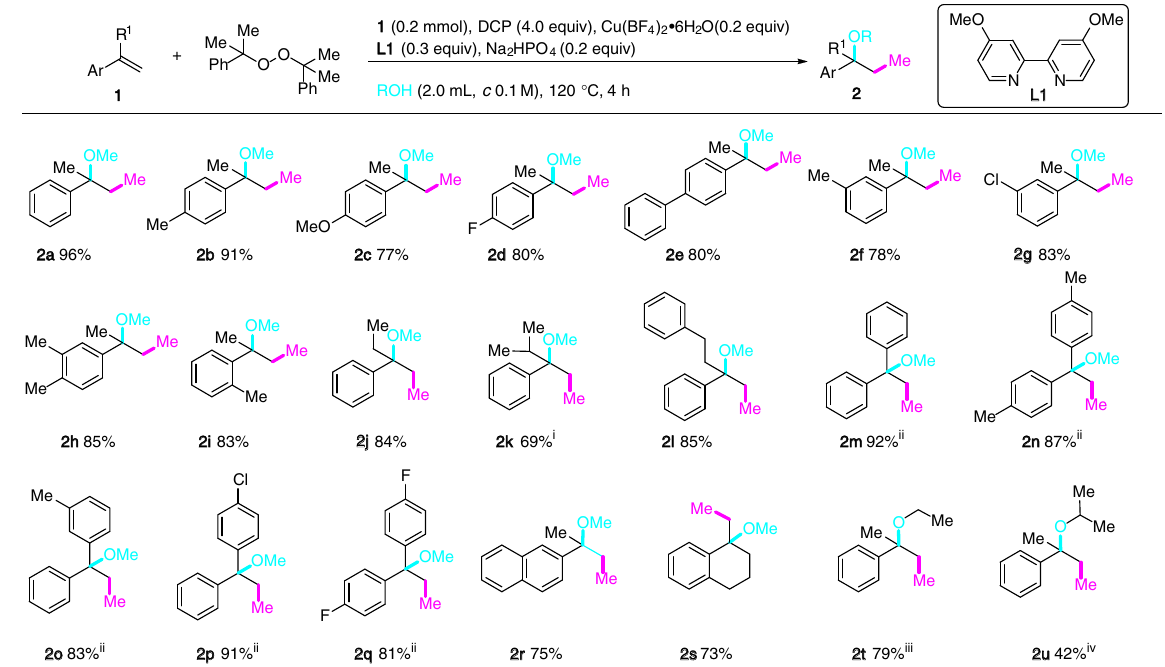
Fig. 2 1,2-Alkoxy methylation of unactivated alkenes. Unless speci fi ed, MeOH was used as solvent. (i) 140 °C; (ii) DTBP (4.0 equiv) was used instead of DCP; (iii) EtOH (2.0 mL, c 0.1 M); (iv) i PrOH (2.0 mL, c 0.1 M). Abbreviations: DTBP di- tert -butyl peroxide; DCP dicumyl 2-hydroperoxy-2-methylbutane as ethyl donor under otherwise standard conditions provided a complex reaction mixture. The scope of this 1,2-alkoxy methylation of alkenes is shown in Fig. 2. Electron-donating (Me and OMe) and electron- withdrawing (F and Cl) substituents at different positions of the phenyl ring of the α -methylstyrene derivatives were transformed into the corresponding methylated ethers ( 2b – 2i ) in excellent yields. Different alkyl groups (Et, i Pr, and CH 2 CH 2 Ph) at the α - position of styrene were compatible ( 2j – 2l ) and the 1,1- diarylethylenes were similarly difunctionalized to afford the desired products ( 2m – 2q ) regardless of the electronic nature of the substituents on the aromatic ring. 2-Vinylnaphthalene and 1- methylene-1,2,3,4-tetrahydronaphthalene took part in the reac- tion to afford the three-component adducts without event ( 2r , 2s ). However, styrene failed to give the desired 1,2-methoxy methylation product under standard conditions. Performing the reaction of 1a in ethanol and isopropanol under otherwise standard conditions afforded the ethyl ether ( 2t ) and the isopropyl ether ( 2u ), respectively. A gram scale experiment converted 1a to the three-component adduct 2a in 93% isolated yield.